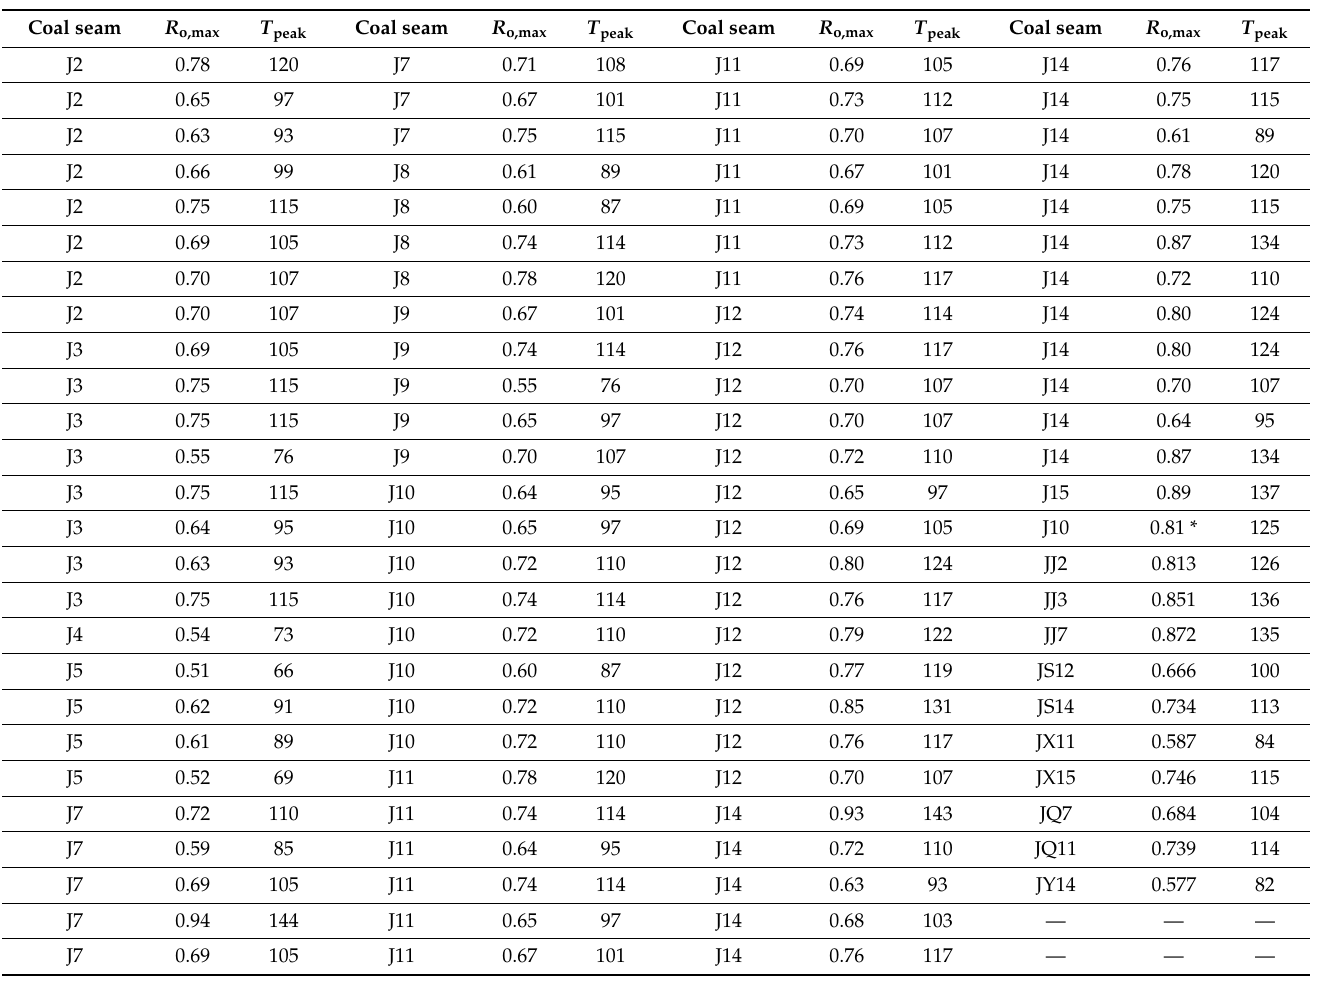
Table 3. The coal vitrinite reflectance (% R o,max ) and the calculated paleotemperature T peak ( ◦ C) for Jurassic Datong Formation.